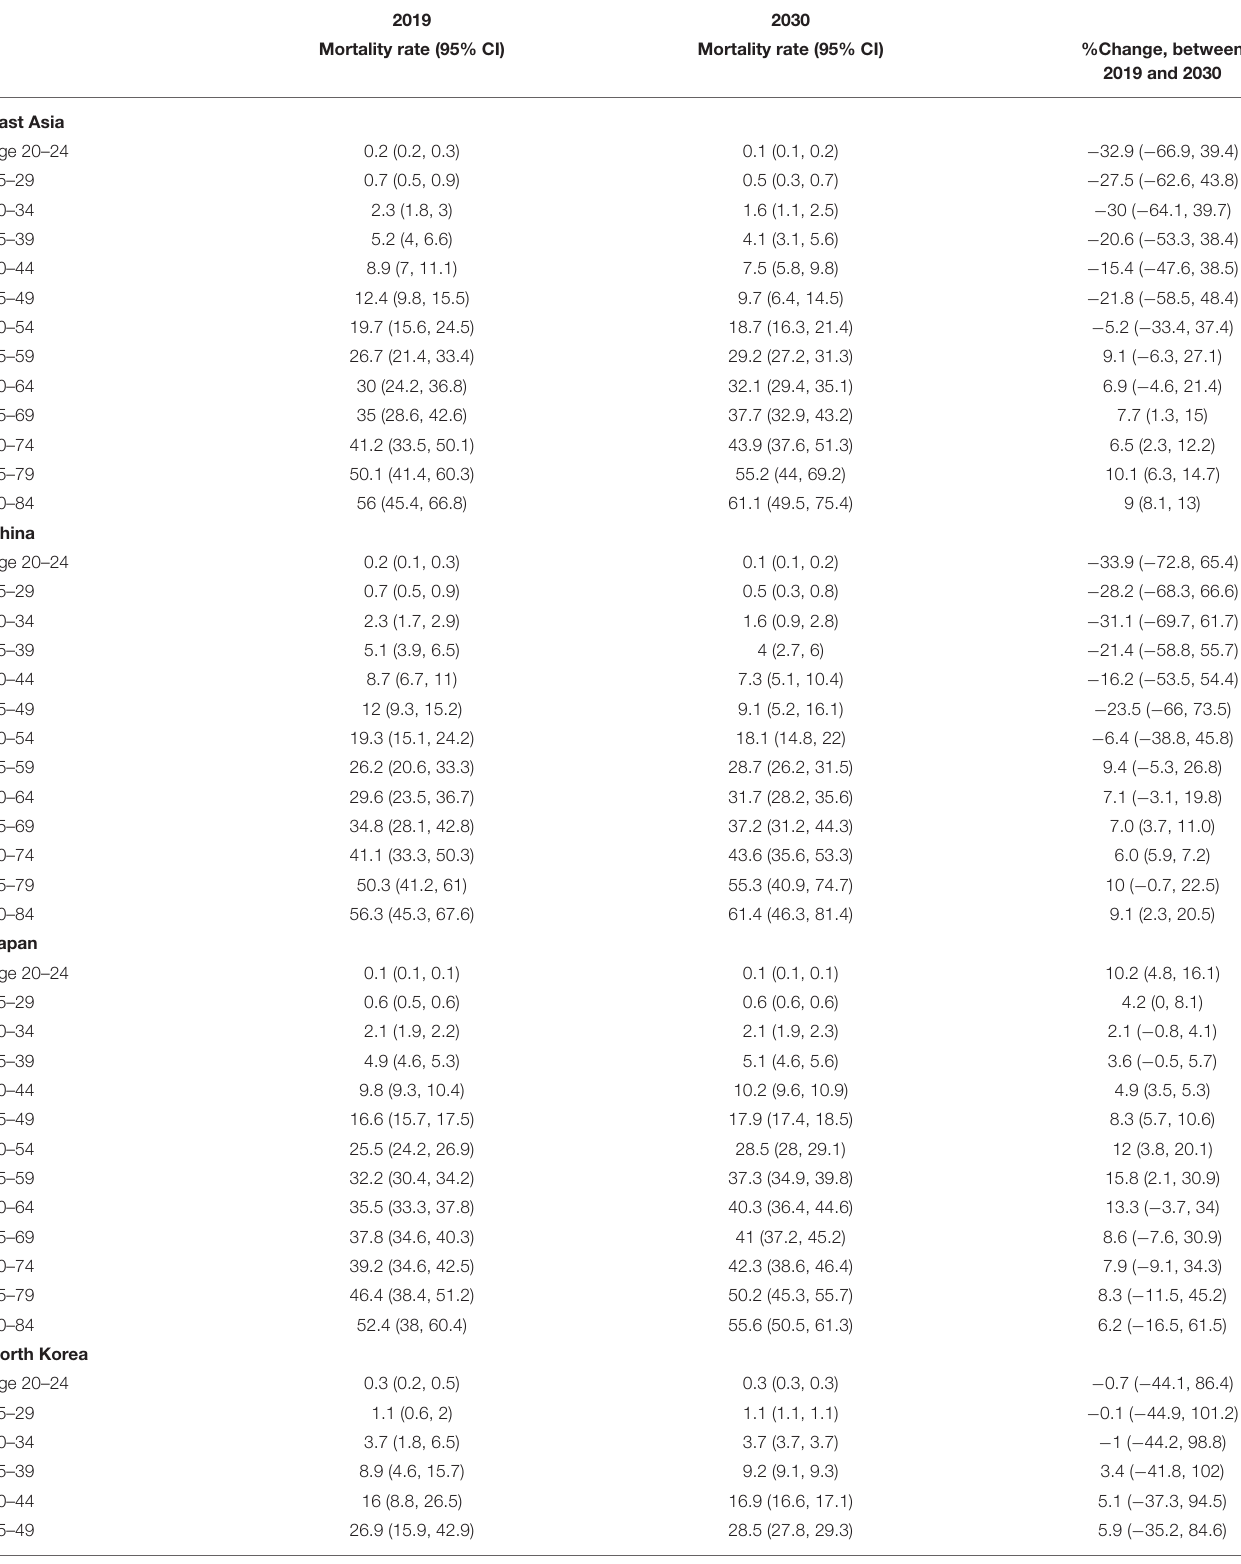
TABLE 1 | Estimated age-specific mortality rates (per 100k), percent change between 2019 and 2030, for breast cancer, in East and South Asian